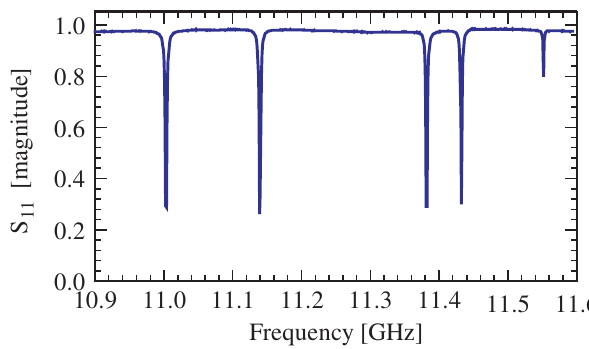
Fig. 11. Primary interest is in the matching of the (cid:3) mode on axis field profile to its design prediction, which is shown in Fig. 12; the overall agreement is very good.